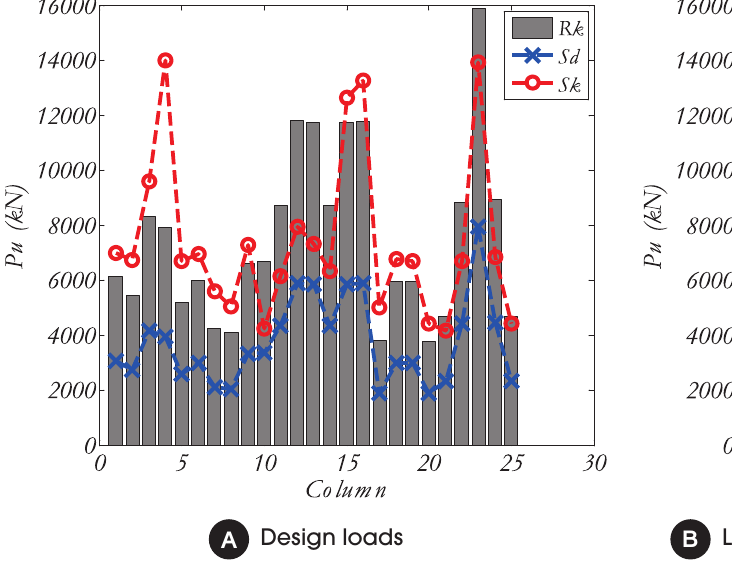
A Design loads B Loads at the moment of collapse (v = 23 m/s)